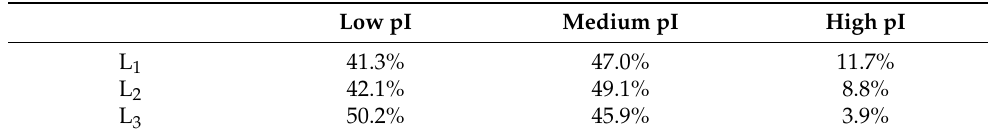
Figure 2. Isoelectric point distributions of the detected corona proteins on ( A – C ) healthy and ( D – F ) PDAC coronas for ( A , D ) L 1 , ( B , E ) L 2 and ( C , F ) L 3 . Table 2. Cumulative abundances of corona proteins with low (pI < 6), intermediate (6 < pI < 8.5) and high (pI > 8.5) isoelectric points for L1, L2, and L3. Values are reported as averages over healthy and PDAC